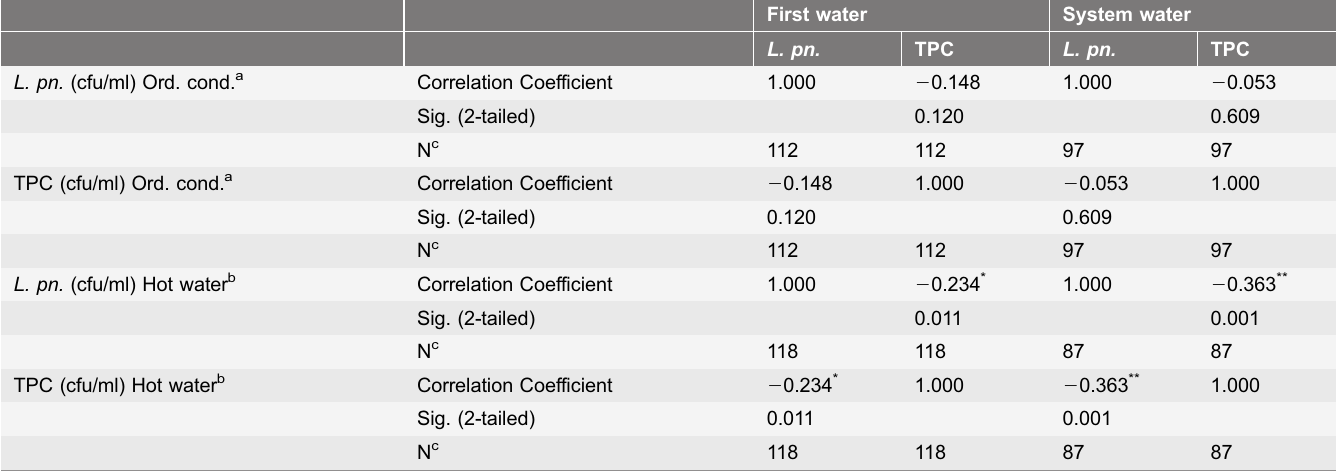
Table 1. Correlation between TPC and L. pneumophila ( L. pn. ) concentration (cfu/ml) in the first water and system water under ordinary conditions and after hot water treatment, respectively.